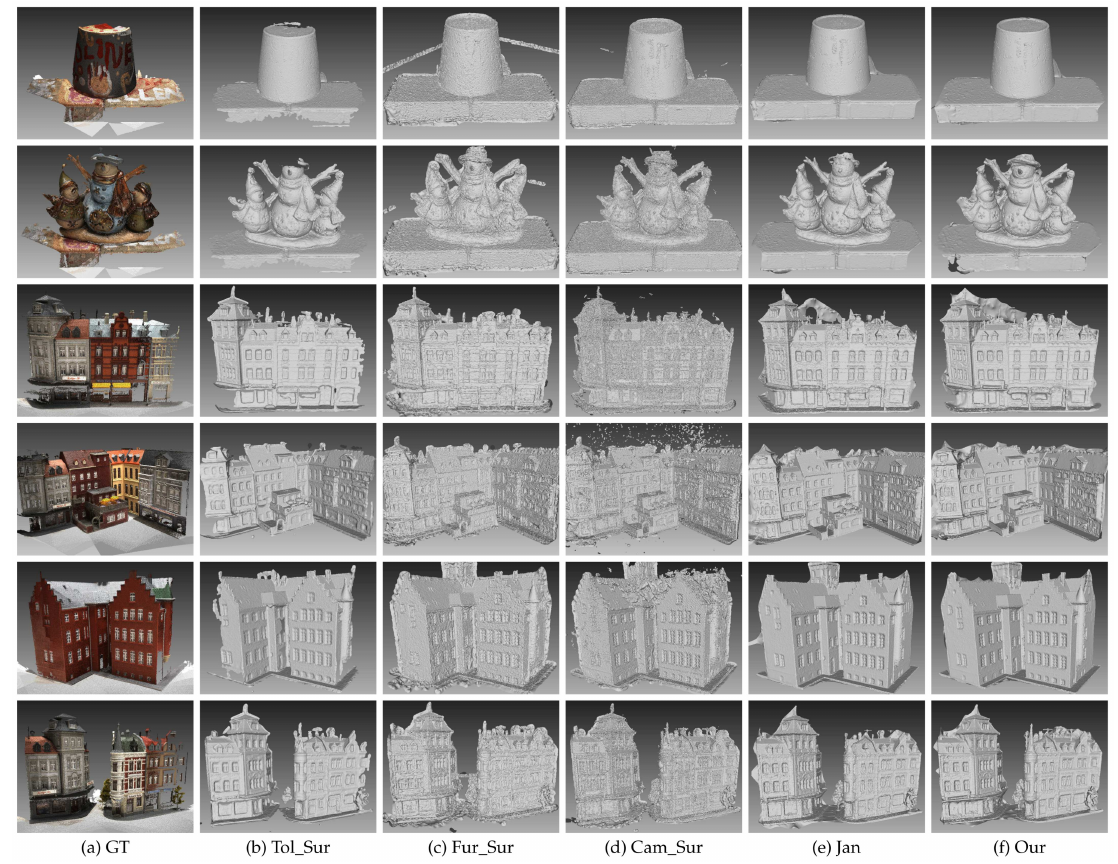
Figure 10. Result of the five methods on MVS dataset [2]. GT is the reference model; Tol is Tola et al. [27]; Fur is Furukawa and Ponce [29]; Cam is Campbell et al. [24]; Jan is Jancosek and Pajdla [5]; Our is the proposed method; and ∗ _Sur is the surface generated by poisson surface reconstruction method [30].